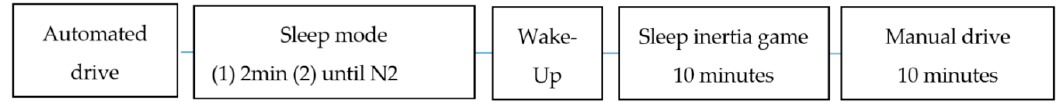
Figure 2. Schematic sequence of the test drive.